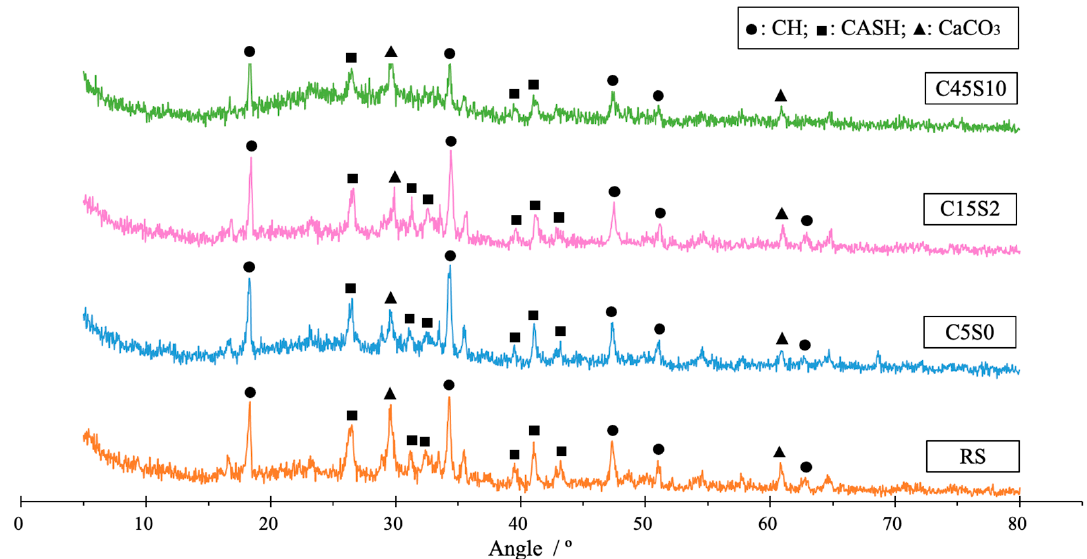
Figure 15. XRD pa tt erns of LWCM. Figure 15. XRD patterns of